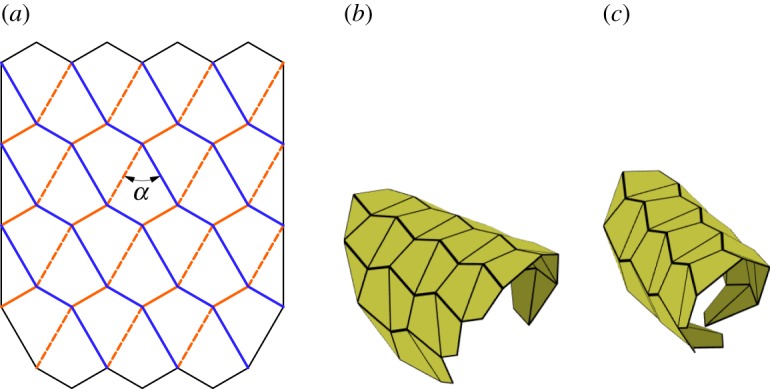
Huffman grid. Mountain folds are indicated by solid lines and valley folds by dashed lines. Fold lines of the same colour have the same fold angle. (a) Fold pattern, (b) partially folded position, and (c) pre-interference position.